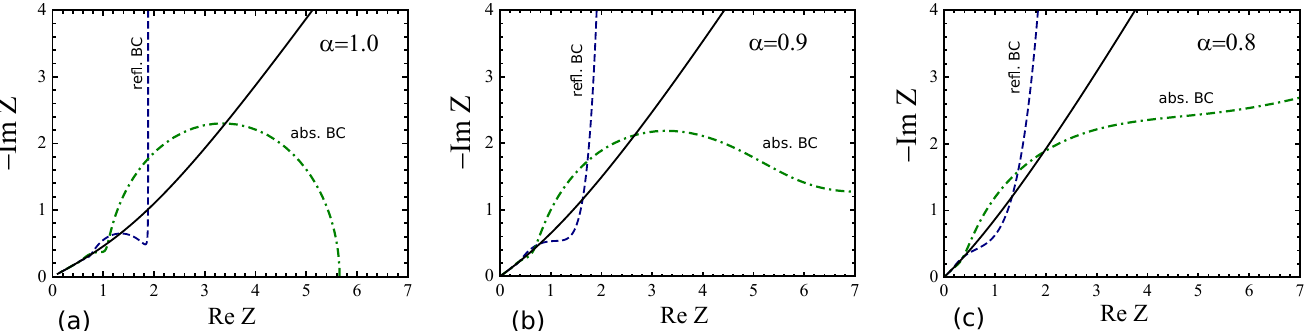
Figure 3. Nyquist plots corresponding to the phase-field subdiffusion ( α = β , χ = 1) for different values of α with reflecting boundary condition, l = 1: ( a ) α = 1.0, ( b ) α = 0.9, ( c ) α =